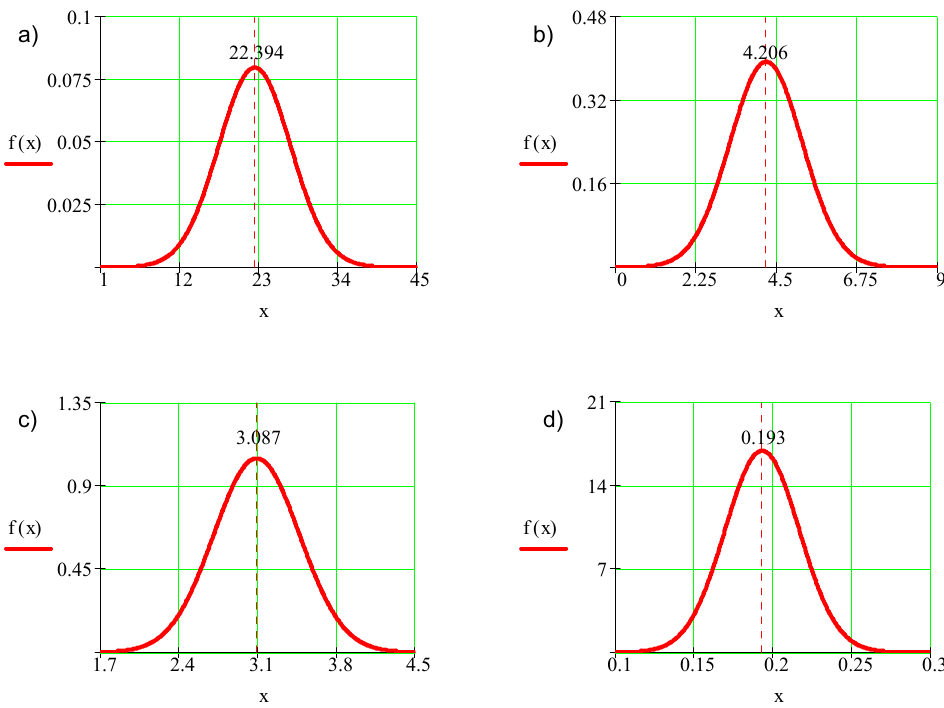
Figure 4. Normal distribution of probability density in the function of the obtained results: ( a ) maximum height of roughness profile— Rz , ( b ) mean arithmetic deviation of roughness profile— Ra , ( c ) relative material ratio of roughness profile— Rmr , and ( d ) mean element width of roughness profile— Rsm .